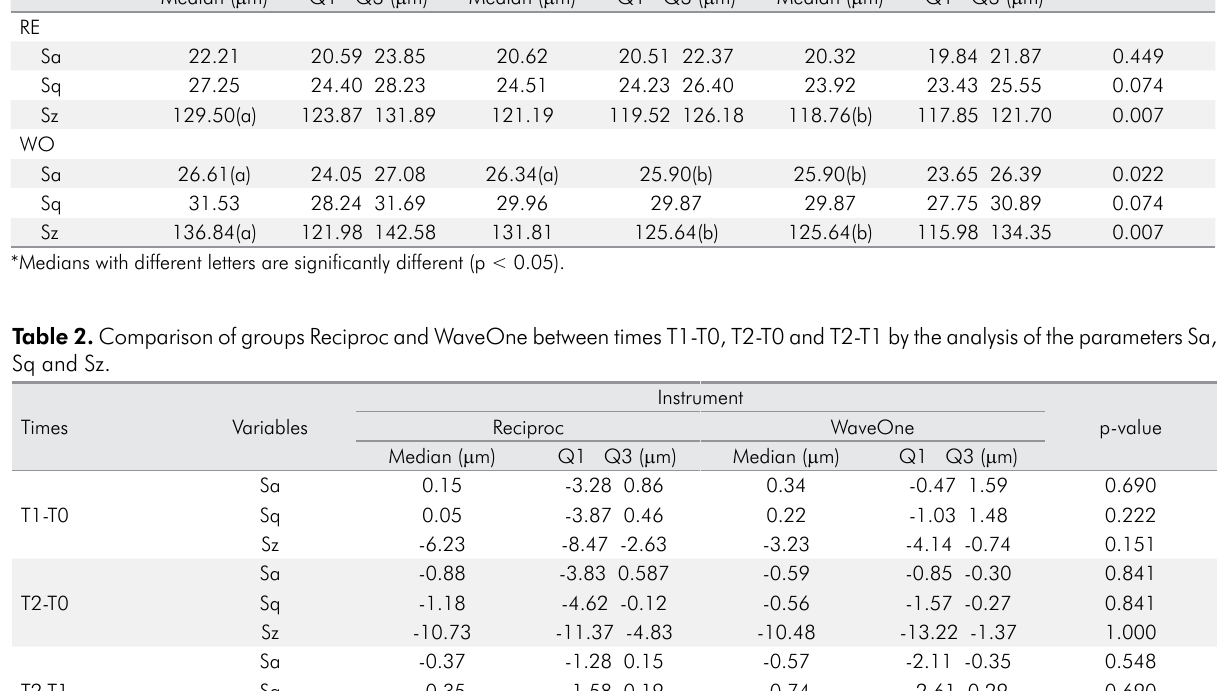
Table 1. Distribution of the values of the parameters Sa, Sq, and Sz for the groups Reciproc and WaveOne at times T0, T1, and T2. Groups and variables